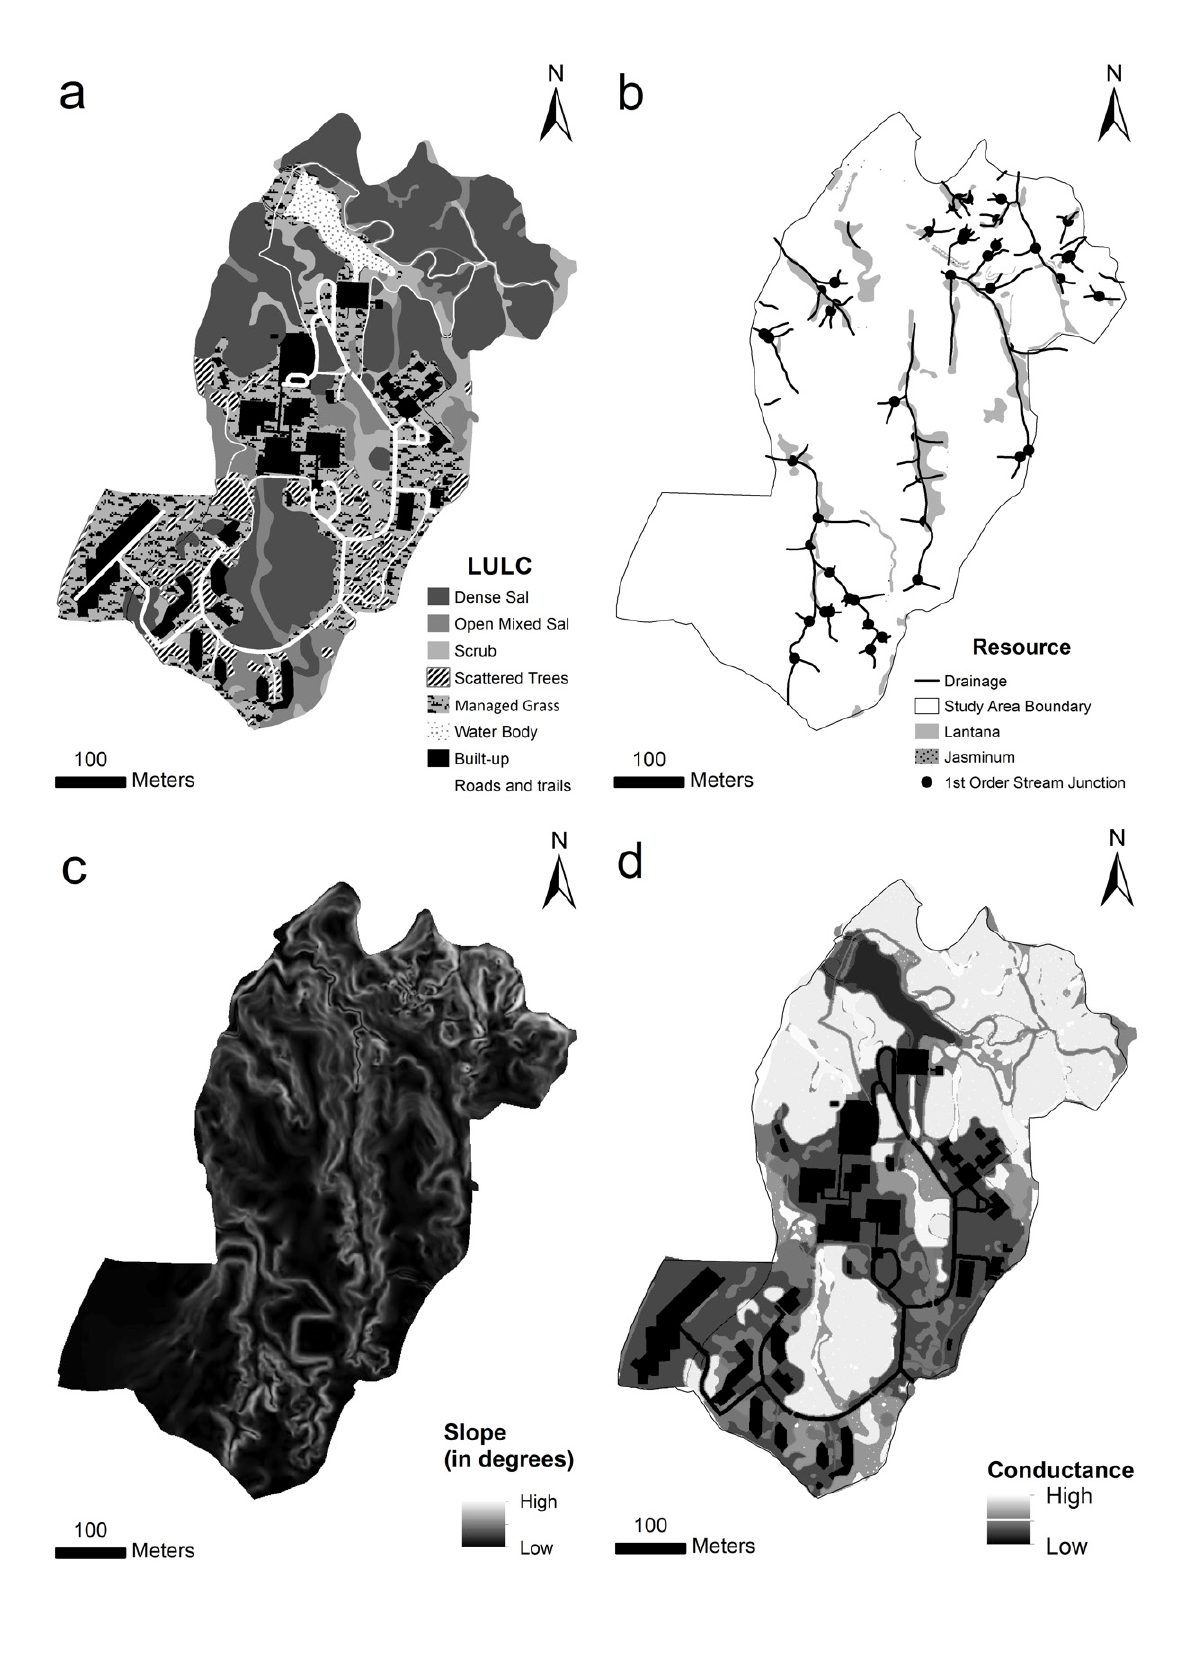
Figure 3. a) LULC map of the study area depicting 7 different LULC classes (Sal: Shorea robusta ). b) Resource map with drainage. c) Slope map. d) Conductance layer after integration of information from figure 3 a, b and